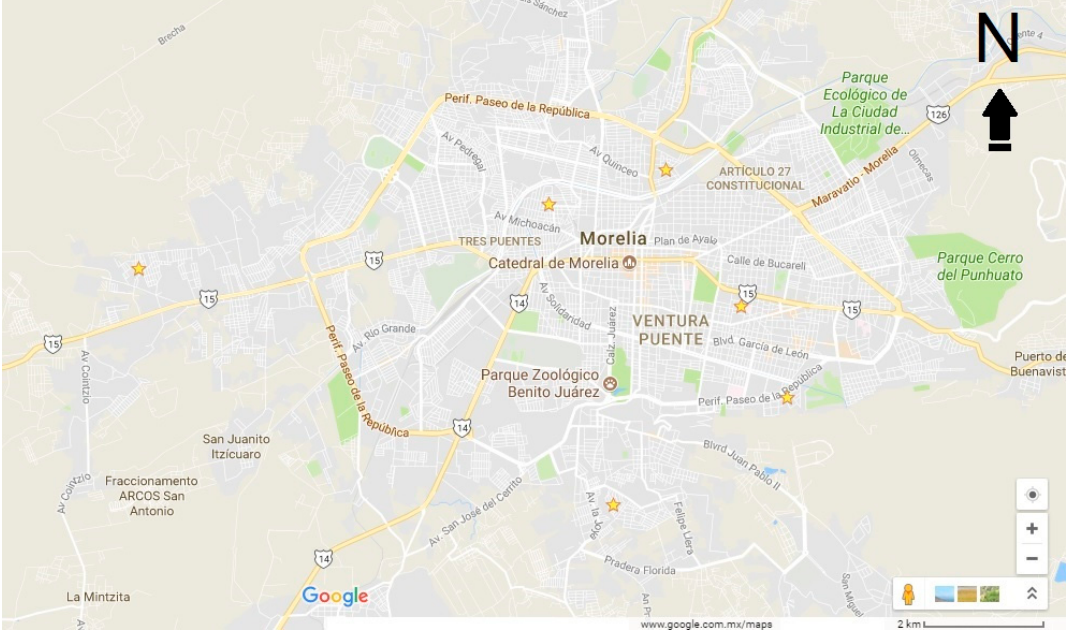
Figure 1. Location of the randomly selected neighborhoods.